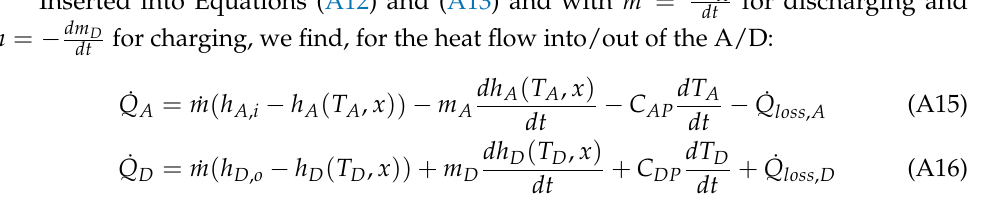
Figure A3. Energy balance of absorber for discharging ( left ) and desorber for charging ( right ). Inserted into Equations (A12) and (A13) and with ˙ m = dm A